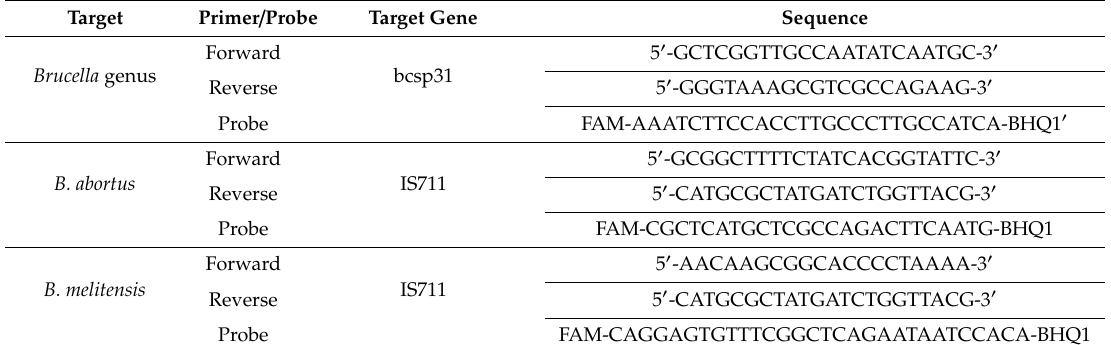
Table 1. Primer and probe sequences used for the detection of Brucella genus and species.